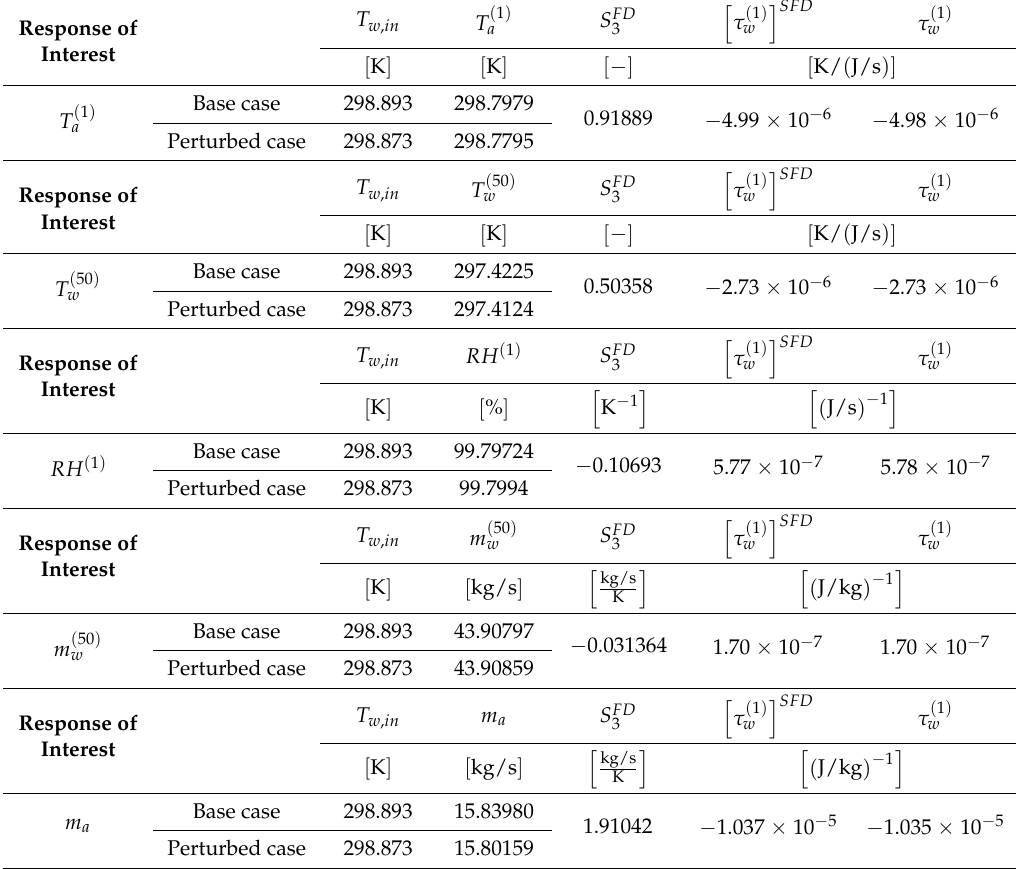
Table E4. Verification Table for adjoint function τ ( 50 ) m w and m a